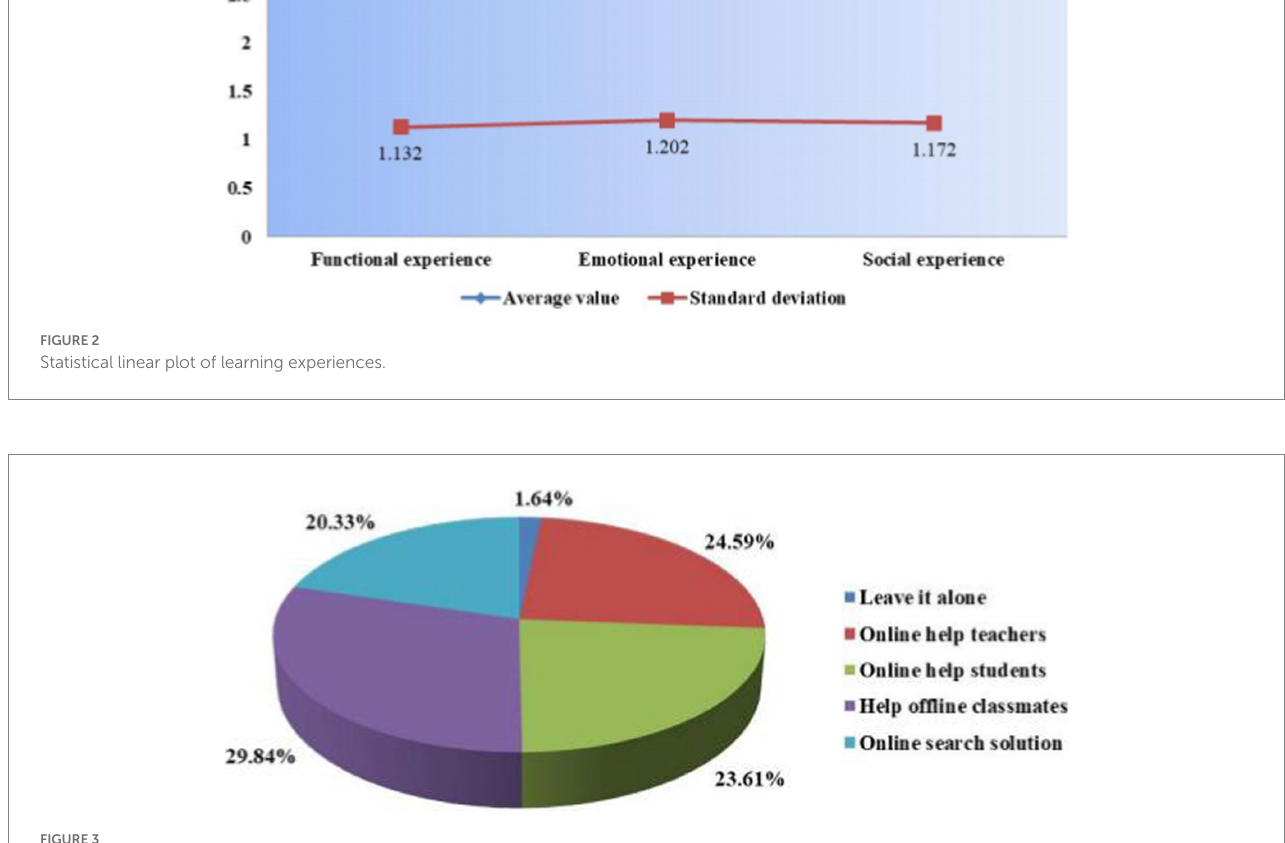
FIGURE 3 Solution statistics pie